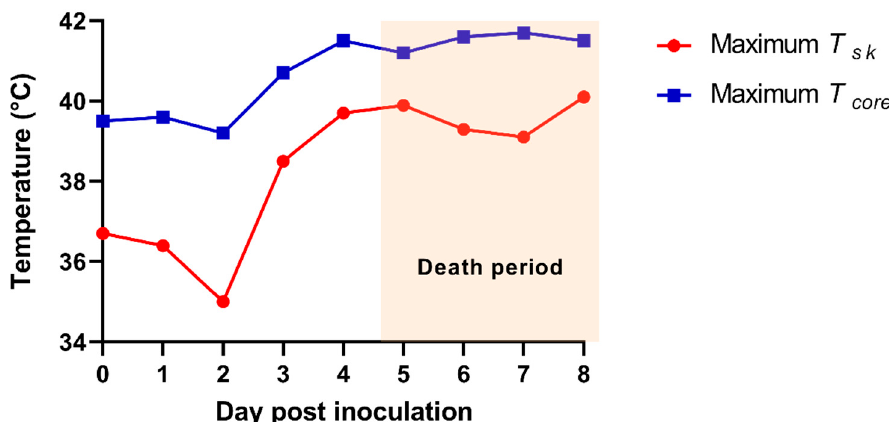
Figure 3. The maximum skin infrared temperature ( T sk ) from the thermal infrared images of the African-swine-fever-virus-infected herd (red line). The maximum rectal temperature ( T core ) of the pig from the African-swine-fever-virus-infected herd (blue line).